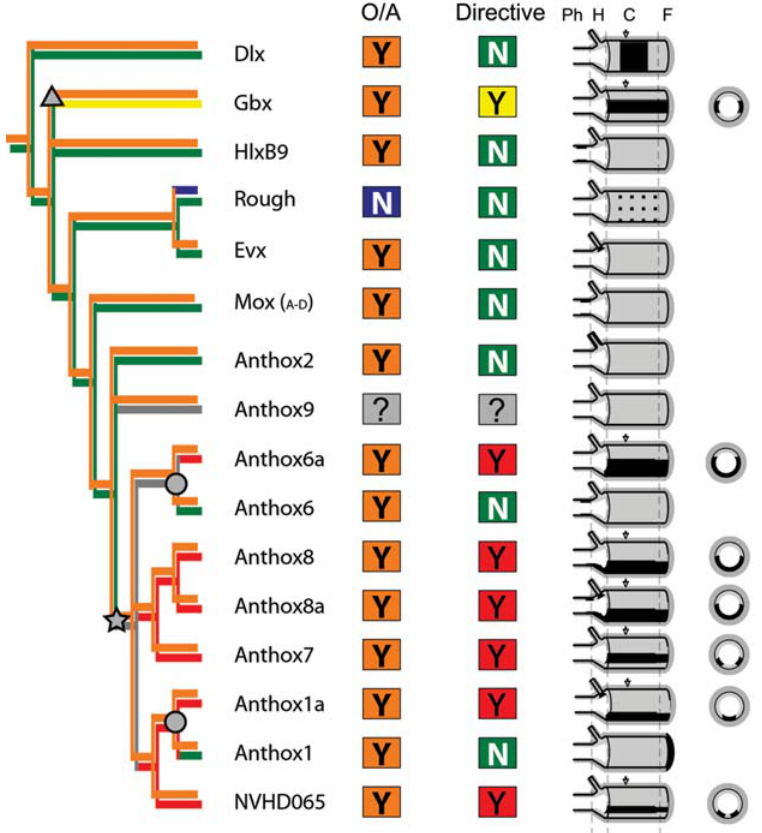
Figure 10. Phylogenetic mapping of Hox expression. The neighbor-joining and Bayesian phylogenies (Figure 2 and S1) were pared to remove all bilaterian sequences. The strict consensus topology shown here depicts the relative relationships among Nematostella sequences. Each of the Nematostella Hox-related sequences is coded according to whether its expression is restricted along the primary (O/A) body axis or the secondary (directive) body axis (Y=yes; N=no). A yellow Y in the directive column signifies that the expression is bilateral (both sides of the directive axis), and a red Y indicates that the expression is unilateral. The character state found in the terminal taxon is indicated in the colored boxes. The internal nodes are shaded to indicate the character states found in hypothetical ancestors. For each gene, the spatial expression is depicted on a diagram of the juvenile polyp. In the case of Dlx, anthox6a and anthox1, the expression pattern that is depicted actually occurs earlier, in the larval stage, but it is represented on a diagram of the polyp to facilitate spatial comparisons with the other genes. The polyp is drawn in lateral view with the overlying ectoderm (dark gray) partially peeled away to reveal the underlying endoderm of the body column (light gray) and the lumen of the pharynx (white). The pharynx is drawn as though everted. Only one representative tentacle is shown. The mesoglea, a largely acellular layer of connective tissue that separates the endoderm from the ectoderm, is depicted as a thin black line. Gene expression is depicted as black shading in the endoderm or ectoderm. The major regions along the primary body axis are demarcated with dotted lines: Ph=pharynx; H=head; C=column; F=foot. Cross- sectional views through the body column (at the arrowheads) are shown for Gbx, anthox7, anthox8a, anthox8b, anthox6a, anthox1a, and NVHD065.